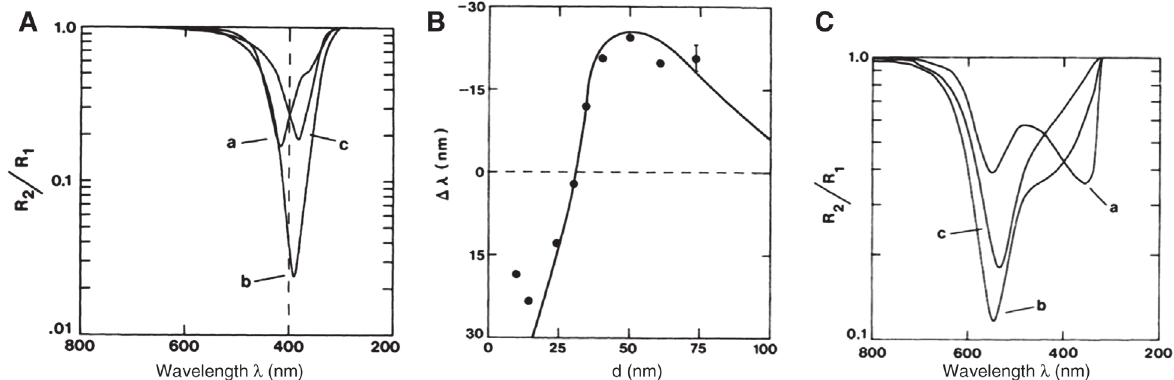
Figure 7: (A) Measured specular reflectance, in the experiment of Holland and Hall [28], of silver-island samples (normalized by Ag-LiF reflectance) as a function of wavelength for three different values of spacer-layer thickness d. Curve a, d = 8 nm; curve b, d = 27 nm; curve c, d = 46 nm. (B) Variation of observed silver-island resonance wavelength shift with spacer-layer thickness. (C) Measured specular reflectance only with gold islands replacing the silver islands as a function of wavelength for three values of spacer-layer thickness. Reprinted figure with permission from W. R. Holland and D. G. Hall, Phys. Rev. Lett., 52, 1041–1044, 1984. Copyright (1984) by the American Physical